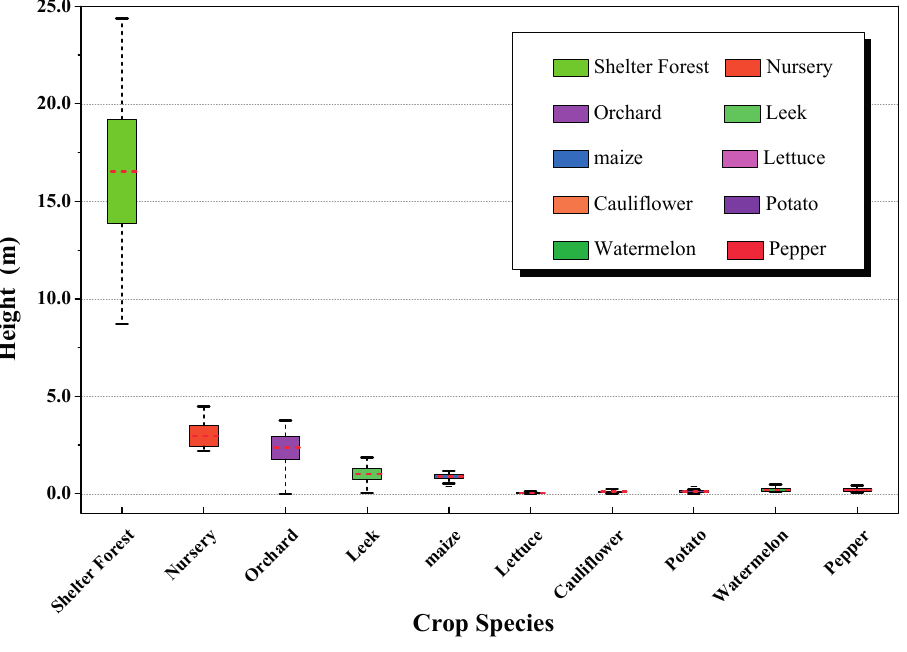
Figure 8. Crop height box plot of the 10 crop